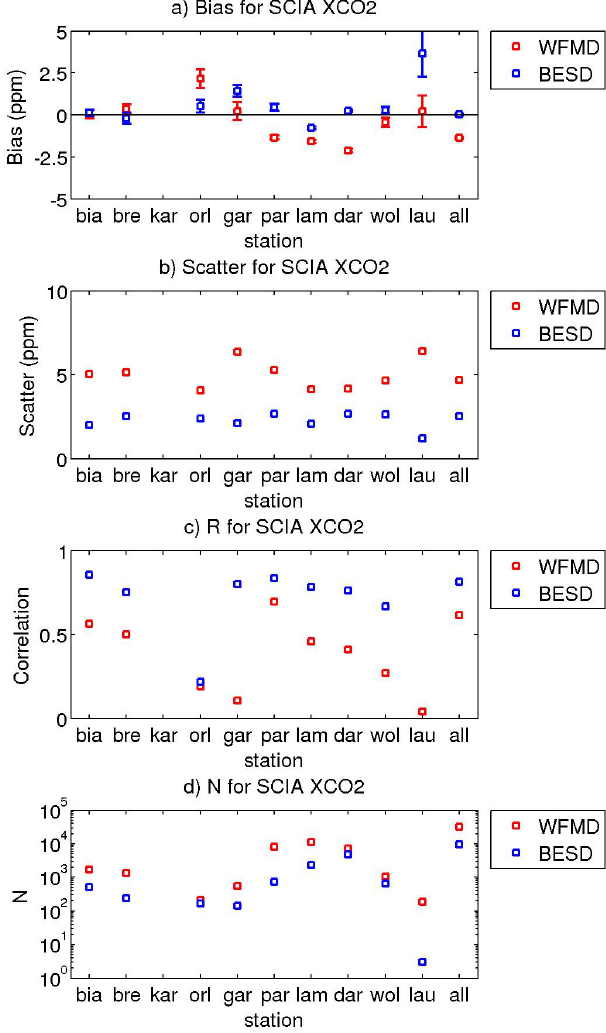
Figure 3. SCIAMACHY XCO 2 bias (a) , scatter (b) , correlation (c) and number of data pairs (d) , for all individual TCCON stations and all data